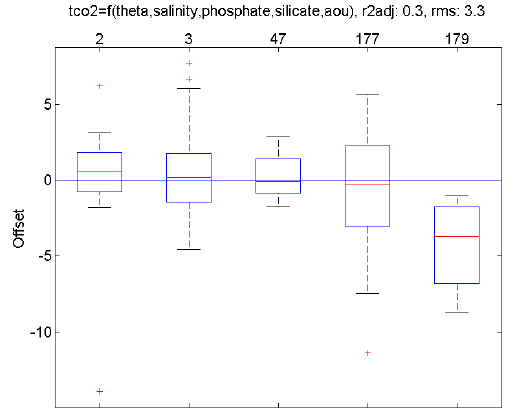
Figure 5. MLR results for TCO 2 in the Nansen Basin (o ff sets in µ molkg − 1 ).